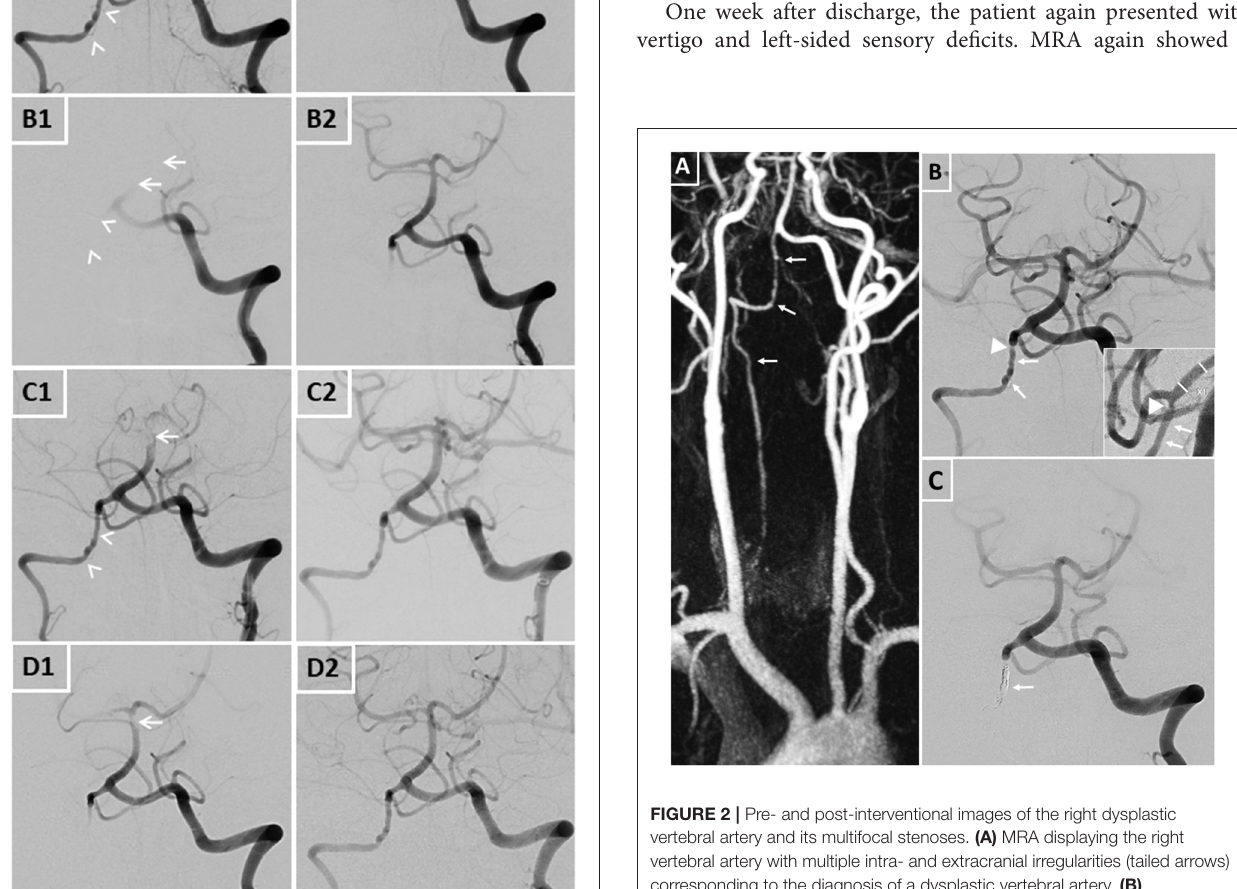
Frontiers in Neurology |